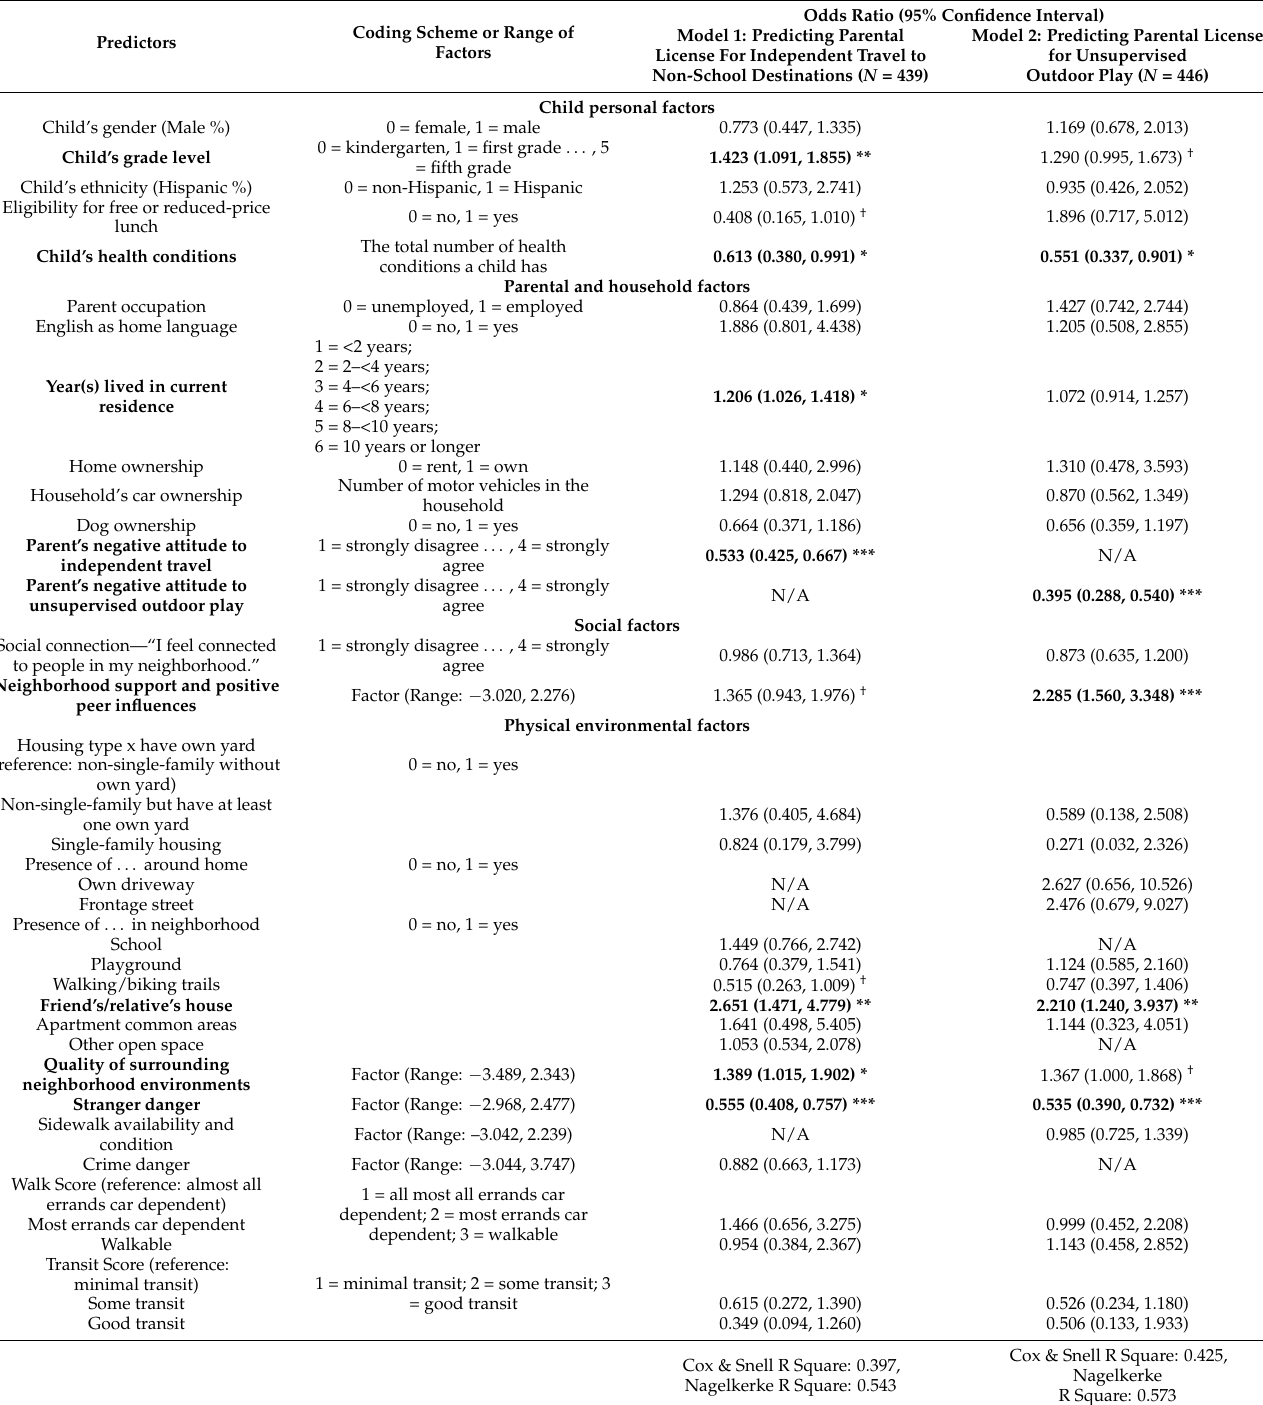
Table 2. Binary logistic regressions predicting parental license for independent travel to non-school destinations and unsupervised outdoor play using personal, social, and physical environment factors Odds Ratio (95% Confidence Interval) Model 1: Predicting Parental Model 2: Predicting Parental License Predictors Coding Scheme or Range of Factors License For Independent Travel to for Non-School Destinations ( N = 439)